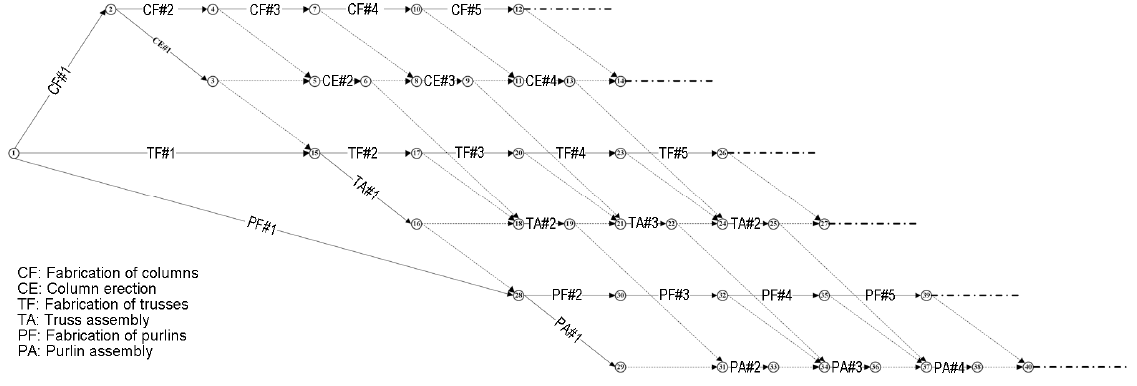
Fig. 4. Logic diagram of the CPM network